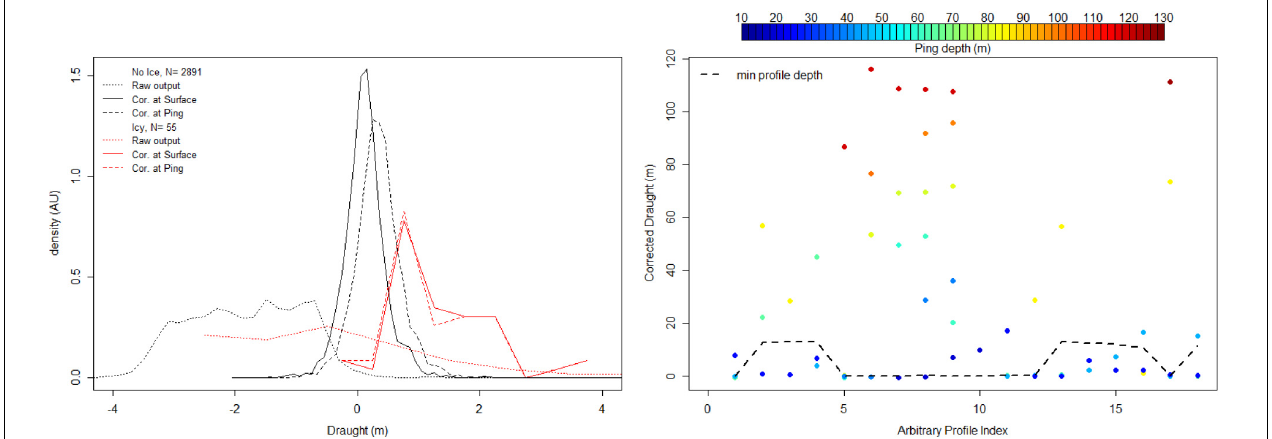
FIGURE 7 | Left : Draught distribution, for draught < 5 m, estimated from sonar raw distance (dotted line), from distance corrected for sound speed at ping depth (Cor. At Ping, dashed lines) or for mean sound speed (Cor. At Surface, solid lines). In black: profiles without ice (August, September, and October); in red: icy profiles (December to June). Right : Draught measurements for the 18 profiles with at least one draught measurement greater than 5 m. Color scale represents the measurement depth, and dashed line, the minimum depth reached for the